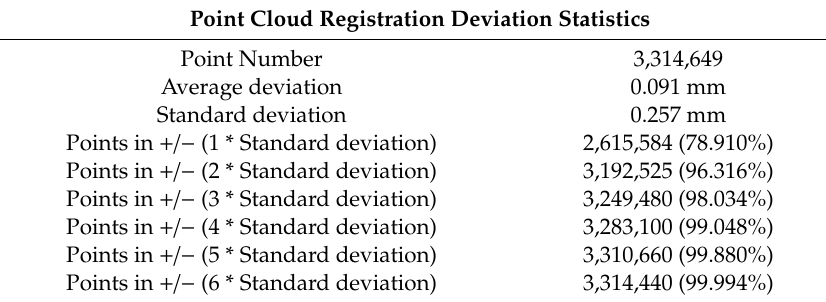
Table 4. Statistical results of registration